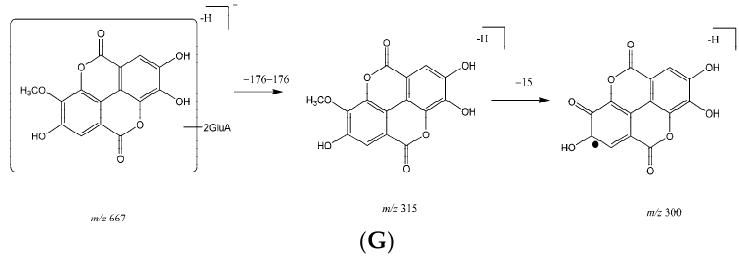
Figure 2. Fragmentation patterns of the in vivo metabolites of FR429: ( A ) M1; ( B ) M2 and M3; ( C ) M4; ( D ) M5; ( E ) M6; ( F ) M7; and ( G ) M8.